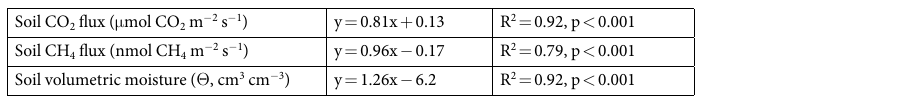
Table 1. Relationships between the two mesocosms during pre-treatment period for measured parameters. These relationships were used to compute the “No Biochar” condition for the treated mesocosm using the Before-After-Control-Intervention (BACI) experimental